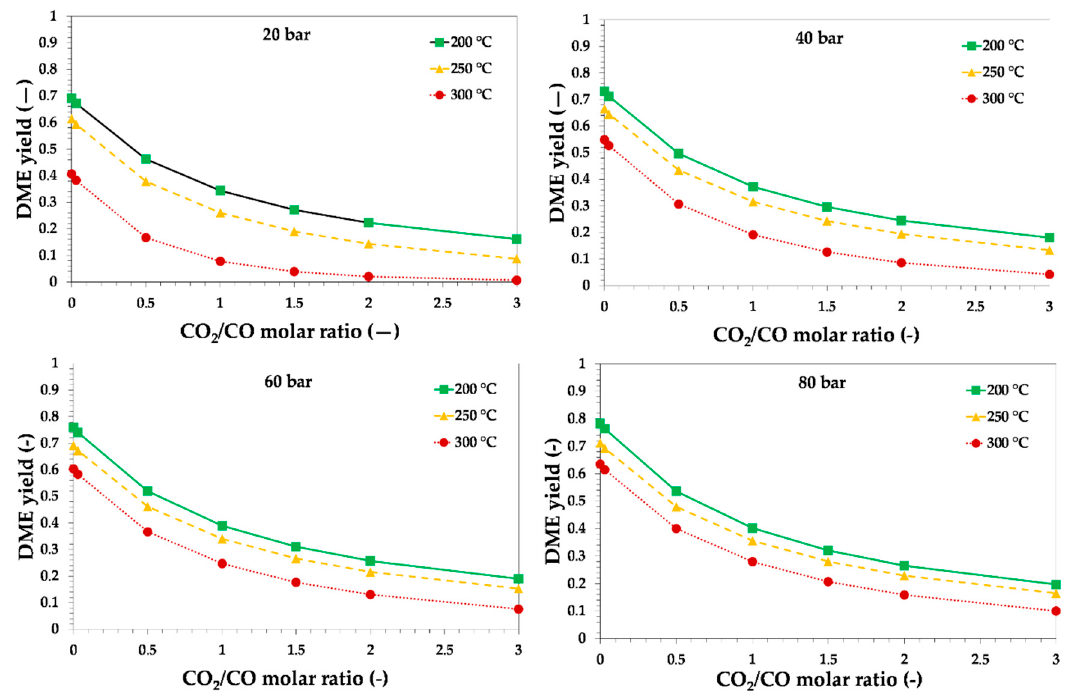
Figure 6. Theoretical equilibrium DME yield as a function of the initial CO 2 /CO molar ratio, reaction temperature and pressure, for syngas with H 2 /CO = 2. Lines are only a guide for the reader.